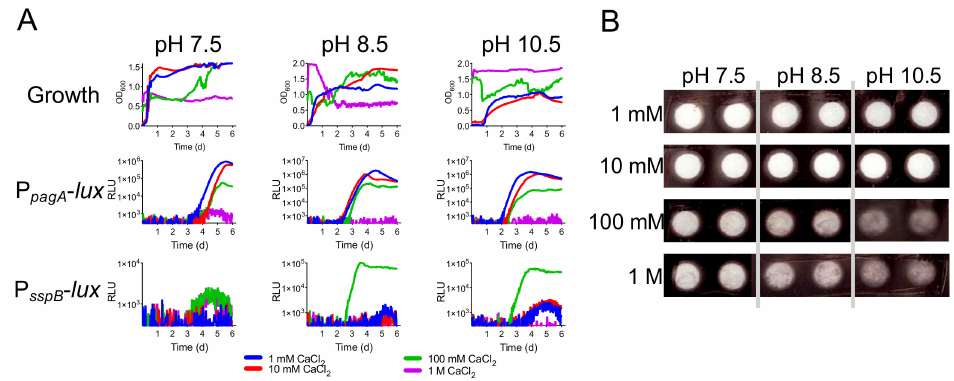
Figure 5. Calcium and pH influence lux expression from P pagA and P sspB . ( A ) Long-term growth (top three panels) and luminescence of P pagA -lux (middle three panels) and P sspB -lux B. anthracis (bottom three panels) across a range of alkaline pH and calcium conentrations. ( B) Image of precipitation of B. anthracis after addition to pH (vertical) and calcium (horizontal) gradients in 96-well plates at dilution of 1:100 at T = 0. RLU, relative luminescence